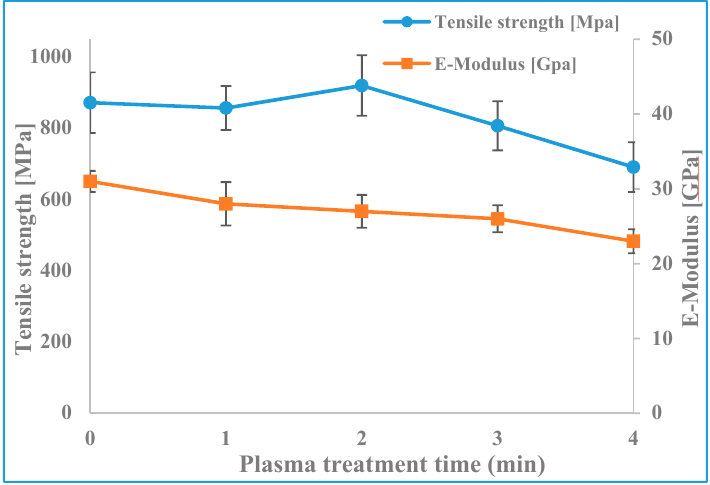
Figure 10. The tensile strength and Young’s modulus of untreated and plasma treated fibers, values based on actual cross-sectional area measurements from SEM images.